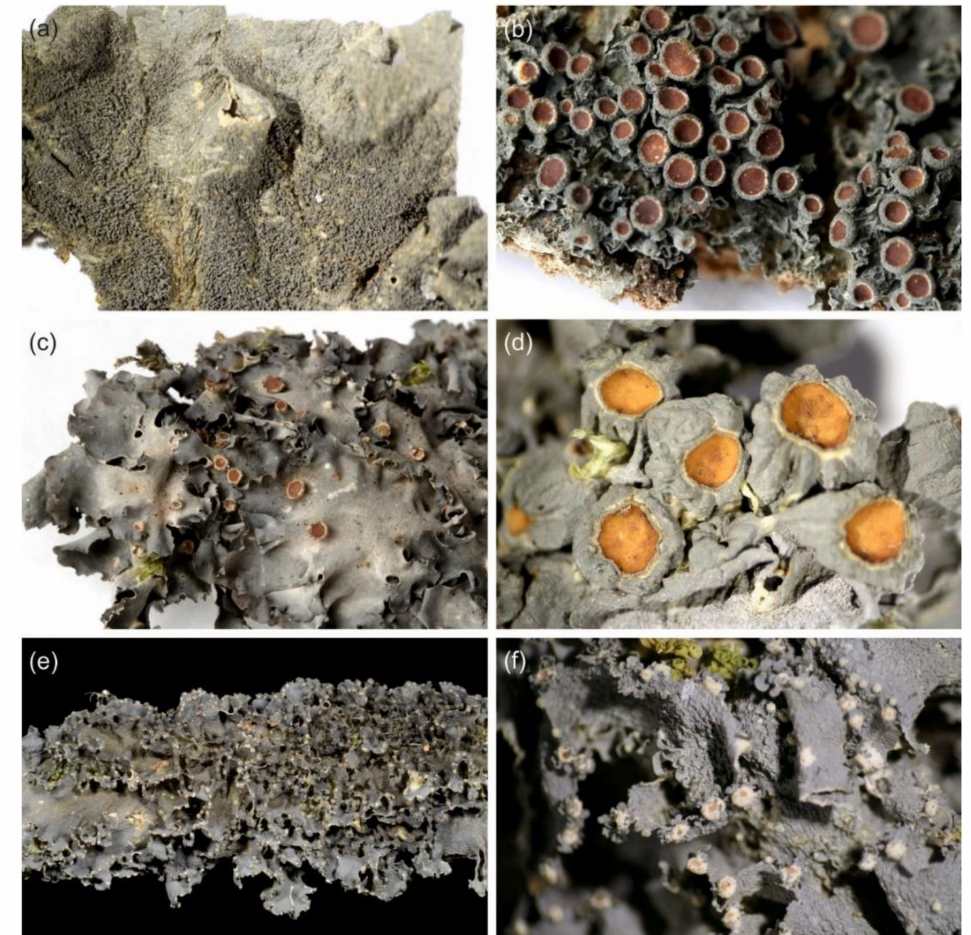
Figure 9. Leptogium species from East Africa. ( a ) Abundantly isidiate and striate to slightly wrinkled thallus of Leptogium austroamericanum (JR10K461). ( b ) Abundantly fertile Leptogium caespitosum with nodular apothecial margins (JR10K401A). ( c ) Leptogium ethiopicum with isidiate apothecial margins (UK171584f). ( d ) Pedicellate apothecia of Leptogium javanicum (JR10119B). ( e ) Leptogium marginellum imaged in situ on a branch. ( f ) The small, phyllidiate, marginal apothecia and wrinkled surface of Leptogium marginellum